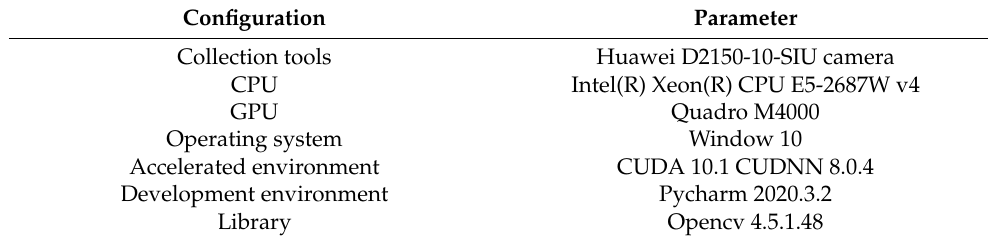
Table 4. The experimental setup.